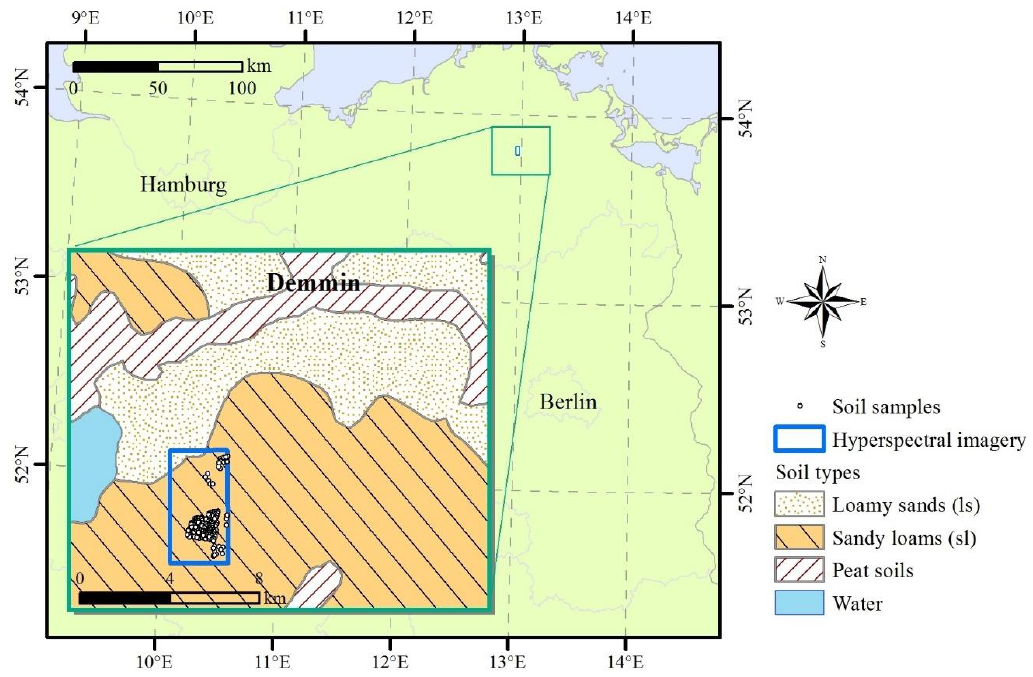
Figure 1. Study site Demmin in the north east of Germany. Data source soil types: BOART1000OB V2.0, (C) BGR, Hannover, 2007.